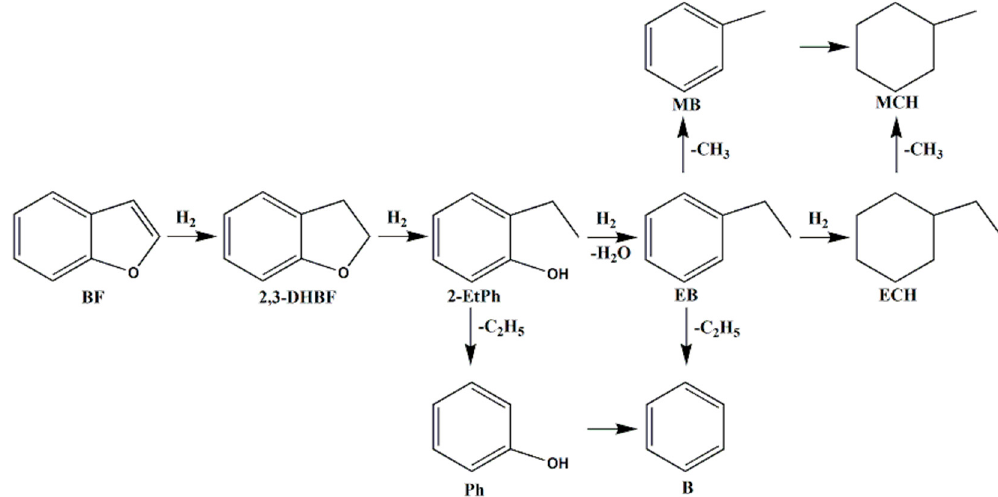
Scheme 1. Proposed reaction network for the benzofuran hydrodeoxygenation (BF HDO) over